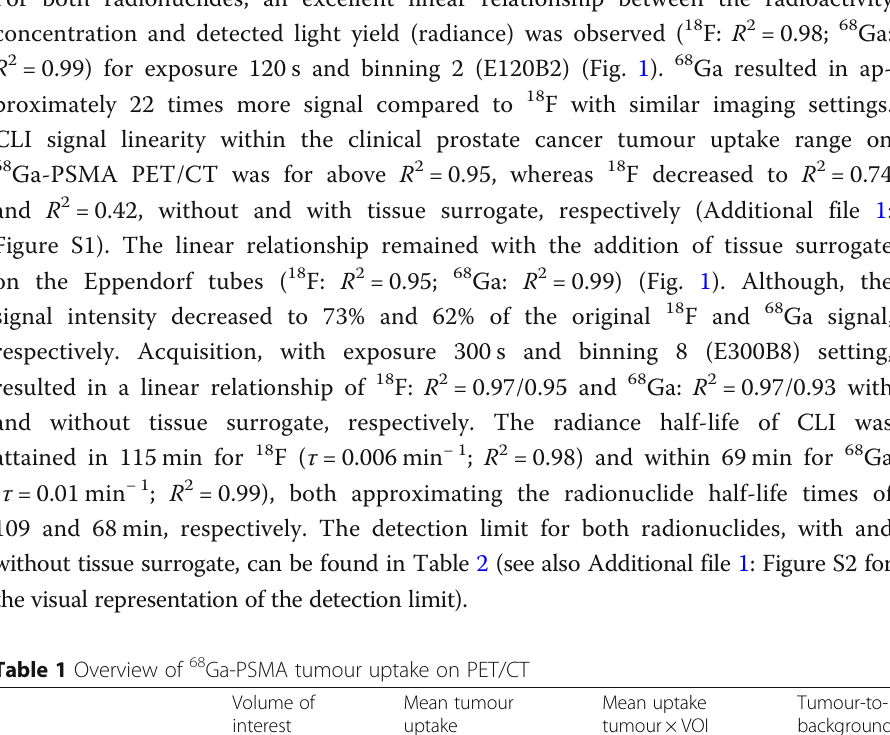
Table 1 Overview of 68 Ga-PSMA tumour uptake on PET/CT Volume of Mean tumour Mean uptake Tumour-to- interest uptake tumour× VOI background (mL) (kBq/mL) (kBq) ratio Average 17.4 3.35 80.96 2.7 Standard deviation 11.4 1.53 71.50 1.1 Minimum 3.3 1.59 11.20 1.2 Maximum 53.0 8.45 275.24 5.7 Median 14.3 2.62 51.35